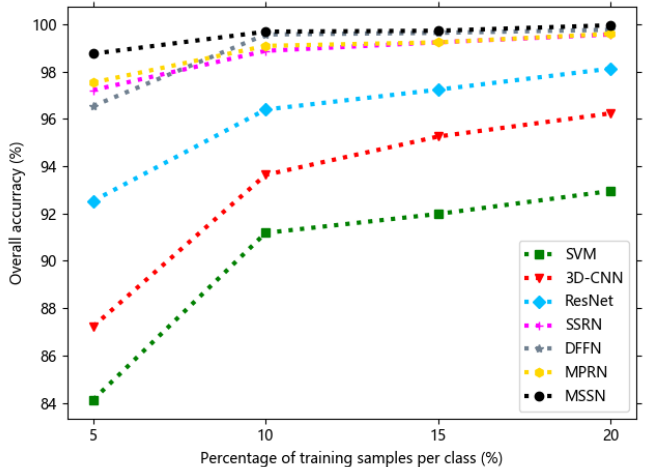
Figure 16. Overall classi fi cation accuracies obtained by different methods when considering different percentages of training samples on the KSC data